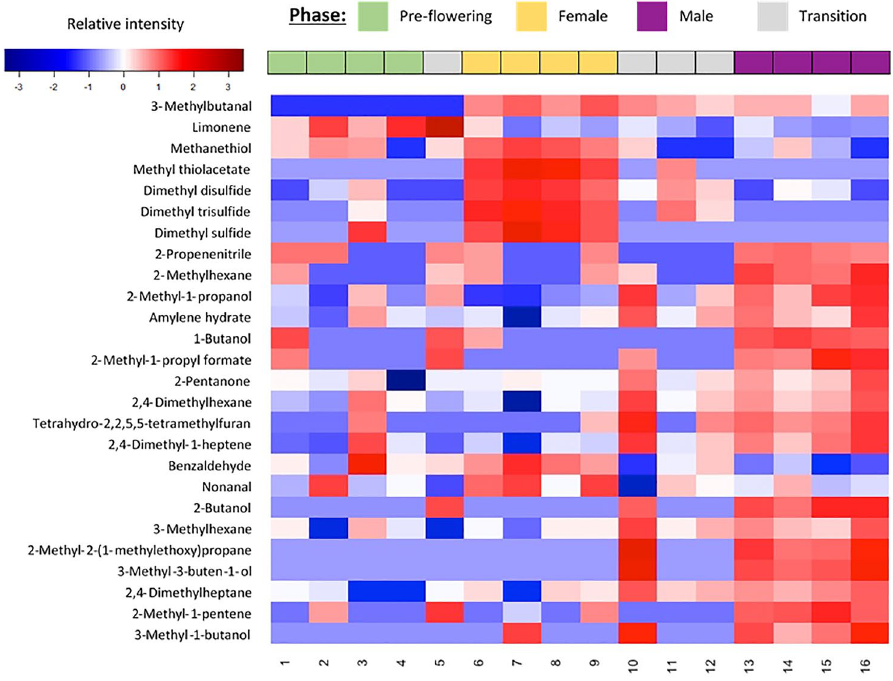
Figure 2. Heat map of the inflorescence’s scent profile over the pre-flowering and the flowering phases using statistically significant